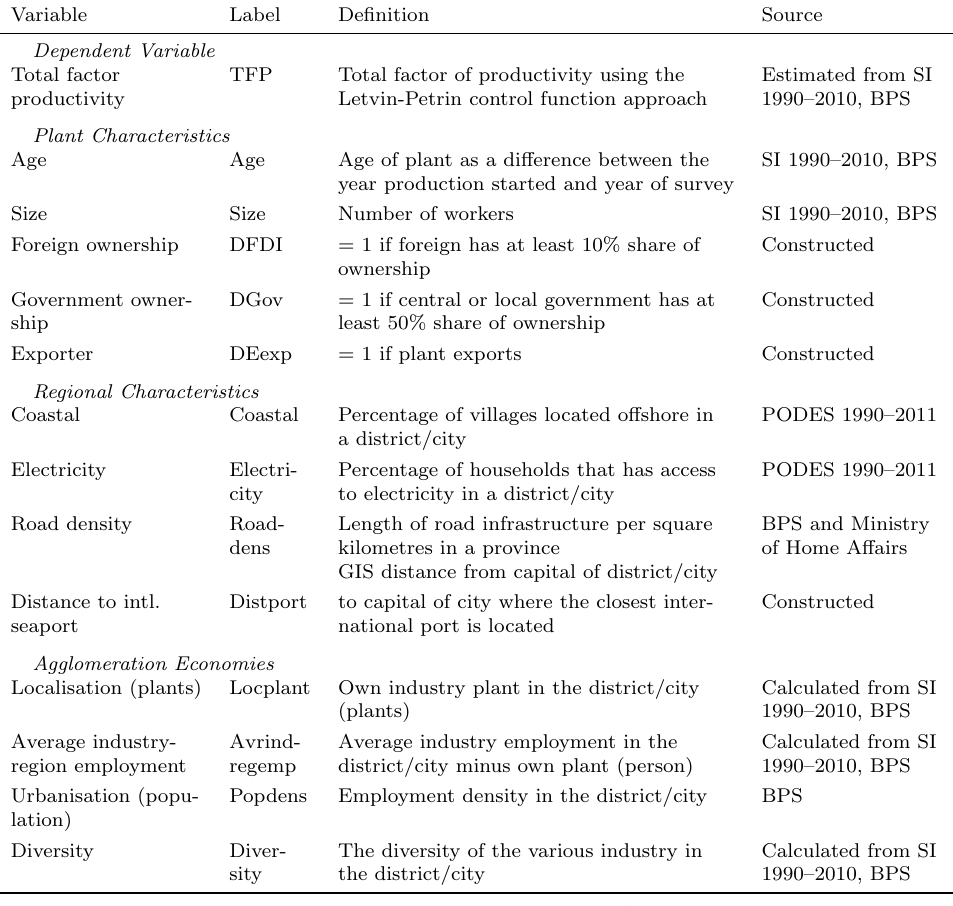
Table A.1: Variable Definition and Data